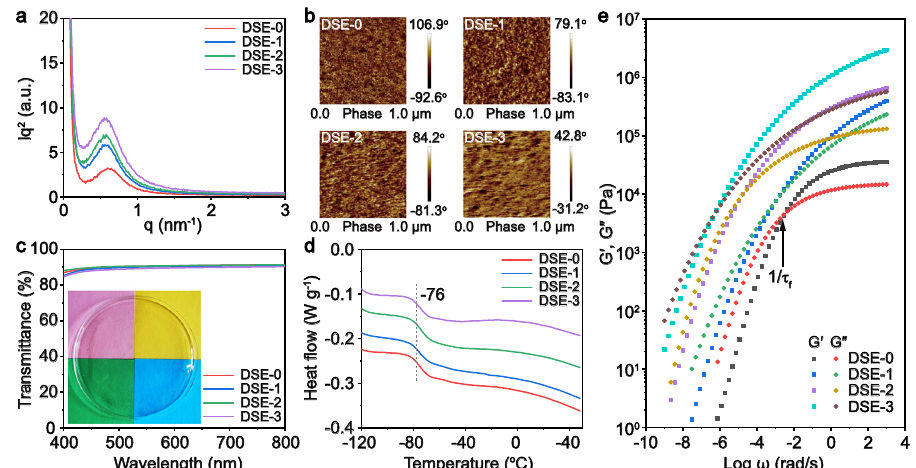
Fig. 2 | Microphase structures of transparent dynamic supramolecular elasto- merswithvaryingamountsofUPymotifs(DSE-0~3).a SAXSpro fi leplotsofDSE- 0~3 that demonstrates the presence of microphase separation on the order of 1 – 3.7nm. b AFM phase images of DSE-0~3.The dark areasrepresent the soft phase and the bright areas represent the hard phase, indicative of the microphase separation structure of DSE-0~3. c Transmittance of DSE-0~3 in the visible range. Insert: photogragh of the as-synthesized DSE, suggesting the high transparency of